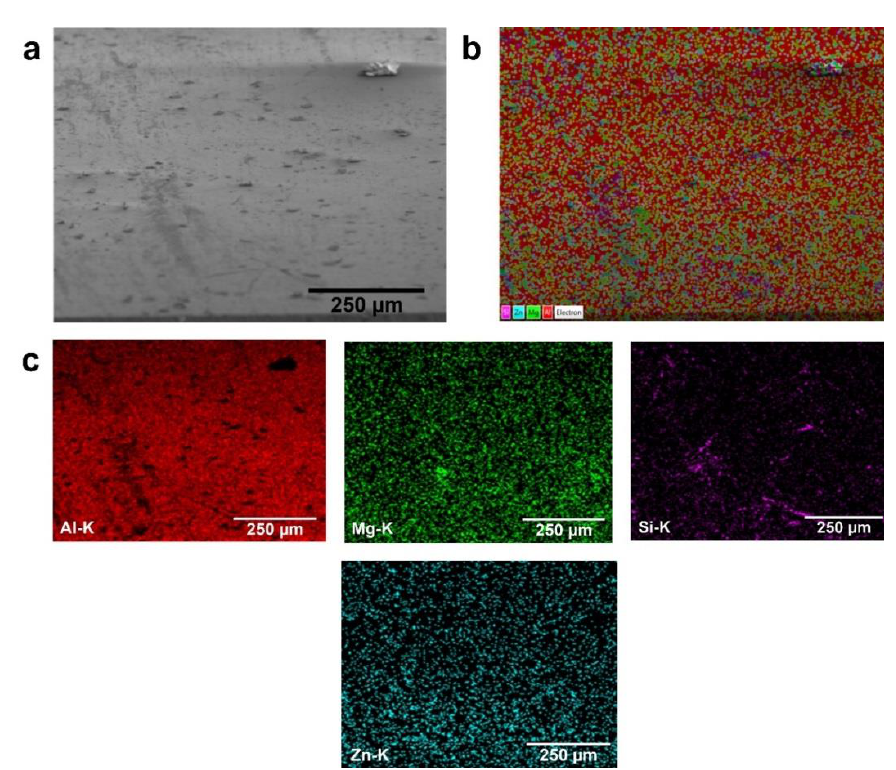
Fig. 3. Elemental composition of ARB Composite